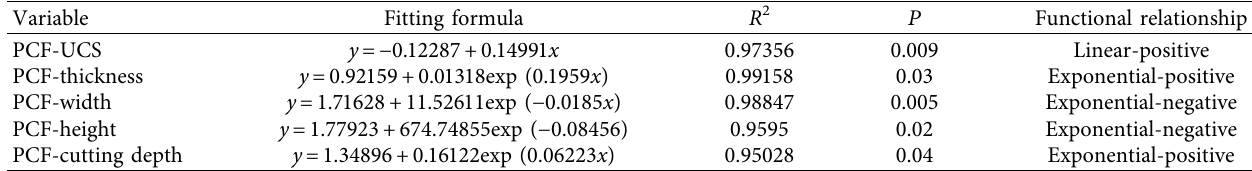
Table 8: The fitting results between PCF and cutting